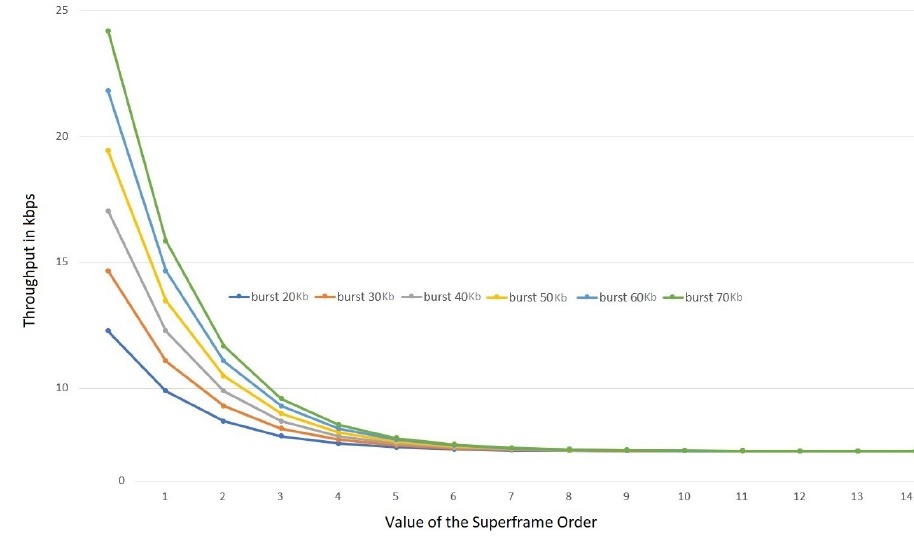
Figure 8. Maximum throughput of a GTS allocation as a function of burst size (low data rates).